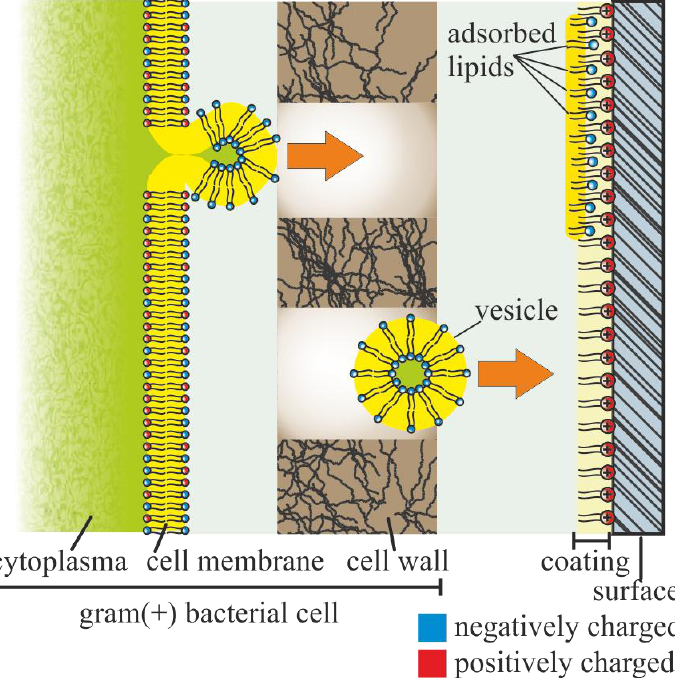
Figure 9. Concept of contact-killing via the phospholipid sponge effect. Created according to